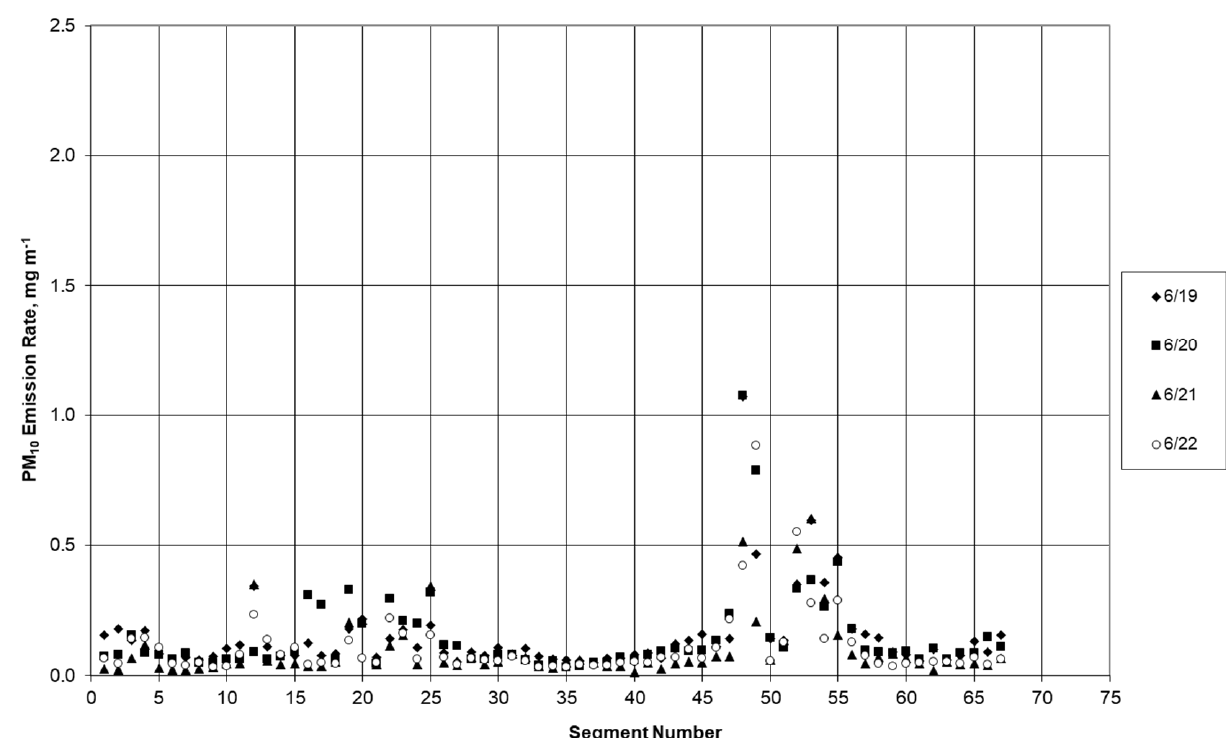
Figure 5. Plot of PM 10 emission rate by segment number starting Monday, June 19 th .